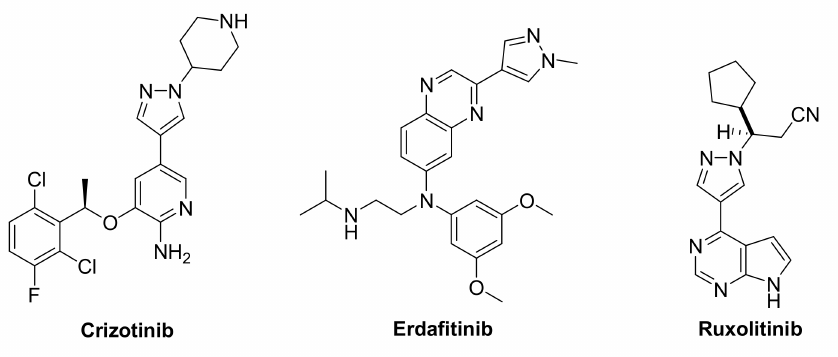
Figure 1. Structures of crizotinib, erdafitinib, and ruxolitinib.